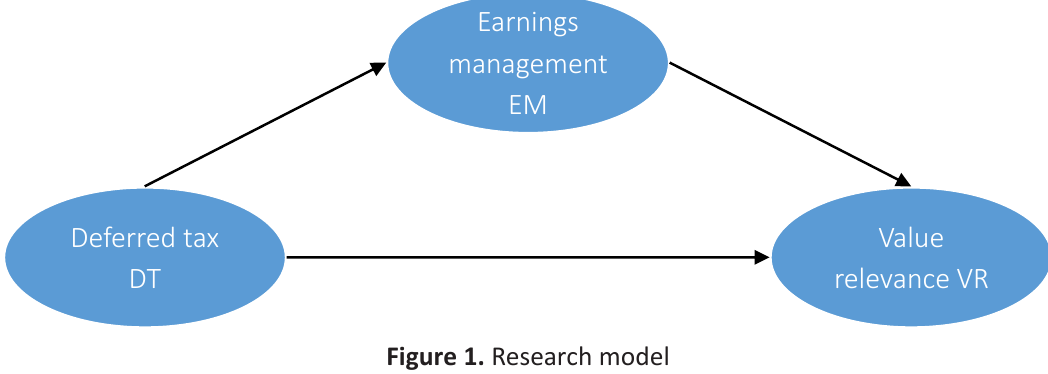
Figure 1. Research